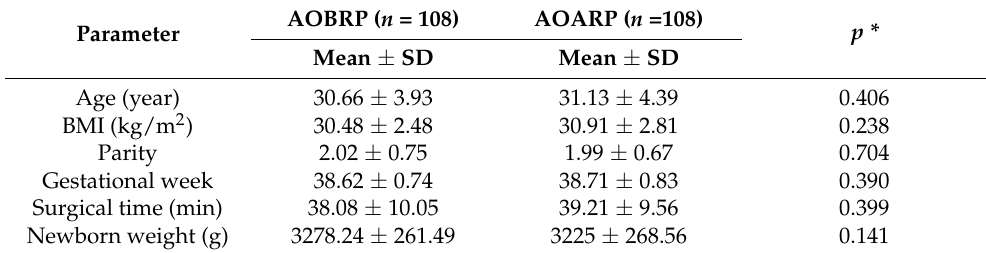
Table 1. Comparison of the descriptive parameters between the two groups. Parameter